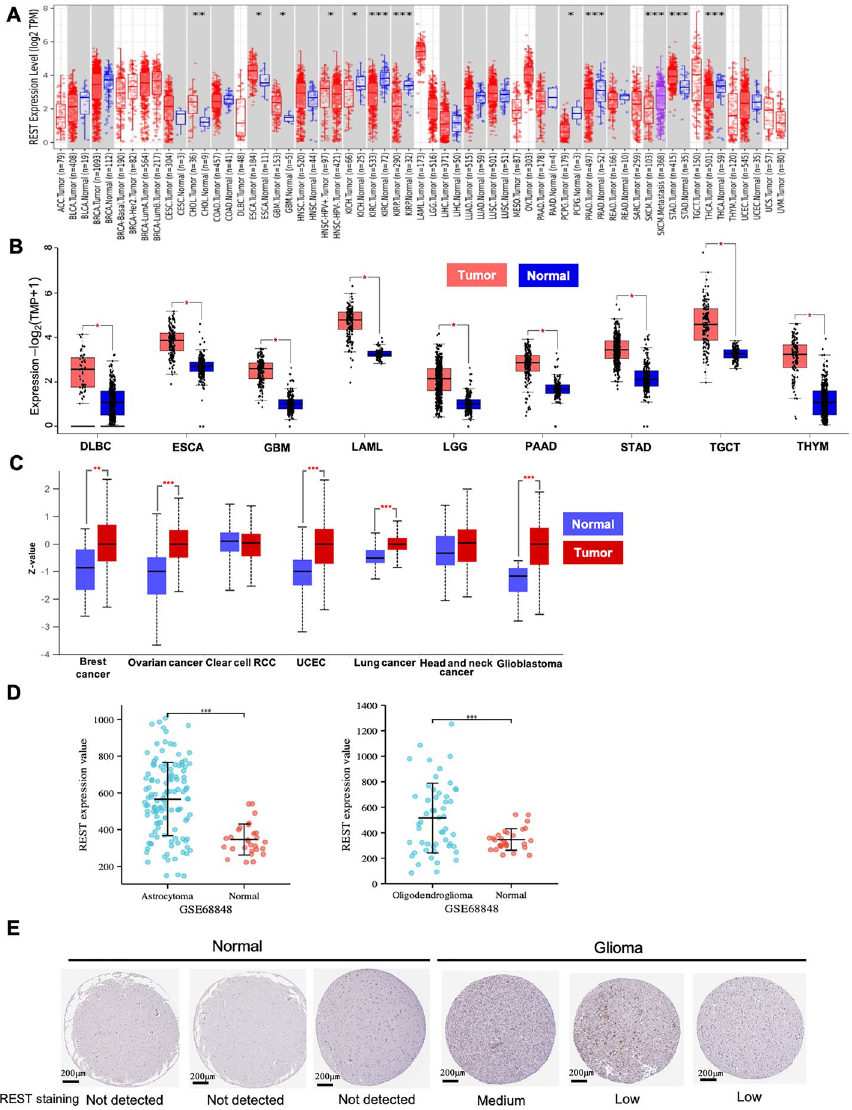
Figure 1. Pan-cancer analysis of REST expression. ( A ) The expression of REST mRNA in human cancers and normal tissues of the TCGA cohort by TIMER2 (http:// timer. cistr ome. org/). ( B ) REST mRNA expression in cancer tissues compared with corresponding TCGA and GTEx normal tissues by GEPIA2 (http:// gepia. cancer- pku. cn/). ( C ) The expression of REST total protein in breast cancer, ovarian cancer, GBM, UCEC and LUAD by UALCAN portal (http:// ualcan. path. uab. edu/ analy sis- prot. html). ( D ) REST mRNA expression in oligodendroglioma and astrocytoma of GSE68848 datasets by GraphPad Prism 9.3.1 (https:// www. graph pad. com/). ( E ) The representative immunohistochemical images of REST in glioma and normal tissues by HPA (https:// www. prote inatl as. org). * P value < 0.05; ** P value < 0.01; *** P value <